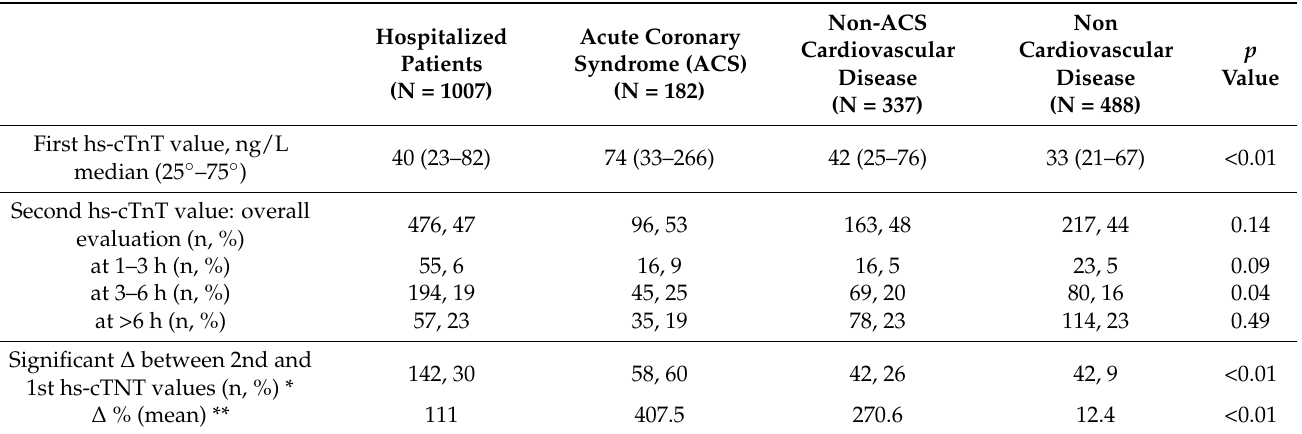
Table 2. Analysis of hs-cTnT values in the overall population and in the three groups of hospital- ized patients.